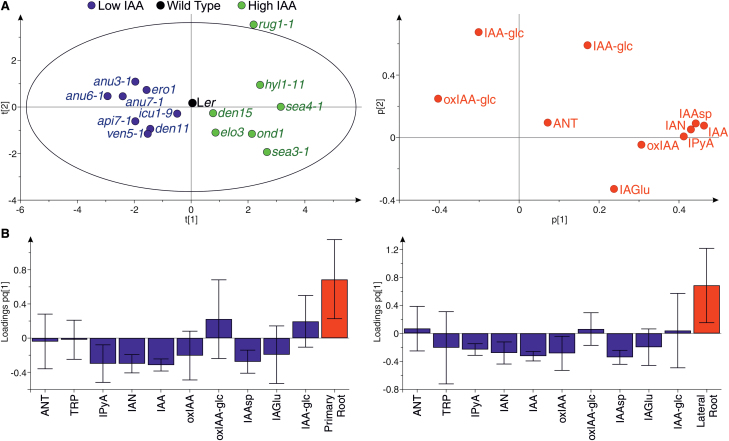
Relationship between IAA metabolites and auxin-related phenotypes in selected lines. (A) PCA on the selected lines in Supplementary Fig. S7 and 10 IAA metabolites. The scatter plot of the scores (left) shows the separation of the lines with higher (green) and lower (blue) IAA levels than in the wild type, based on the metabolites shown in the scatter plot of the loadings (right). The percentage of the variance explained by the components t1 and t2 is 41.9% and 16.5%, respectively. (B) OPLS predictive loadings for PCA models of the primary root length (left) and lateral root density (right) using the selected lines in Supplementary Fig. S7 and 10 IAA metabolites. Model statistics for primary root: one latent variable; R2X=0.377; R2Y=0.292; Q2=0.129. Model statistics for lateral roots: one latent variable; R2X=0.368; R2Y=0.307; Q2=0.049.